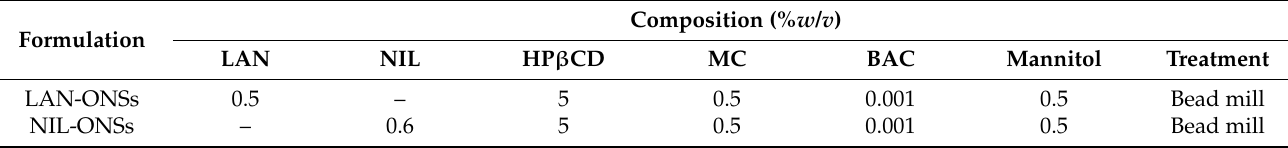
Table 1. Composition of ophthalmic formulations in rat